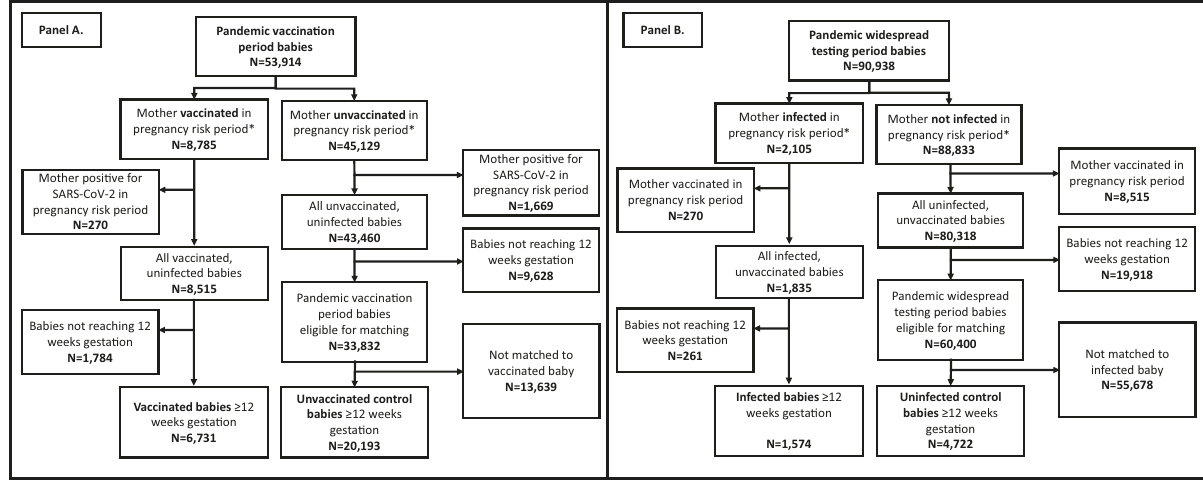
Fig. 1 | Selection of babies for the study. A shows the selection of babies for the analysis of association between COVID-19 vaccination and risk of major congenital anomalies. B shows the selection of babies for the analysis of the association